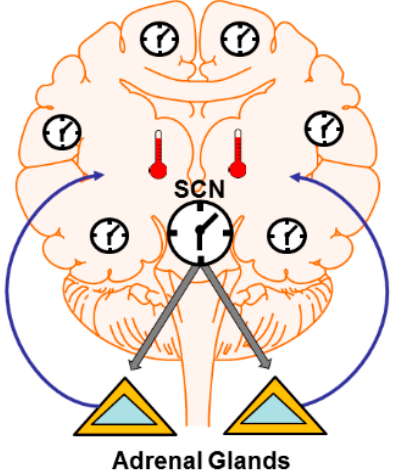
Figure 1. Central and peripheral clocks influence synaptic plasticity. Central clocks like the mammalian suprachiasmatic nucleus (SCN) can impose rhythms in non-clock circuits via several mechanisms. These include rhythms in hormonse and neuromodulator output (e.g., cycles of glucocorticoid release from the adrenal glands) which can alter synapses widely throughout the brain. The SCN also directly drives rhythms in core and brain temperature. Temperature profoundly influences neural function and synaptic plasticity. Temperature may also operate to entrain peripheral clocks in non-SCN neurons. Peripheral clocks themselves can direct plastic changes due to the expression of cannonical clock genes outside central clocks.